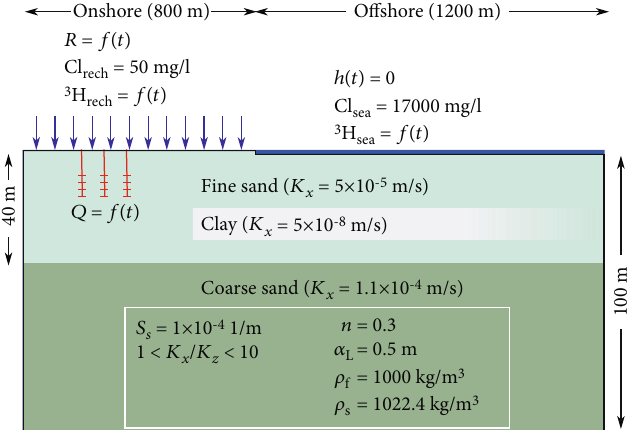
Figure 4: Cross section showing the model dimensions, boundary conditions, and hydraulic parameters for the layers used in the layered simulations. Parameter values in white font were constant in all model simulations. Along the left, bottom, and right boundaries, no- fl ow and nondispersive fl ux conditions were applied. The abstraction ( Q ) and recharge ( R ) time series used are shown in Figures 2(a) and 2(b), ) and seawater ( 3 H ) are shown in Figure 2(b). The fading white colour of respectively. The input time series for 3 H in recharge ( 3 H rech sea the clay layer indicates the uncertainty about its o ff shore